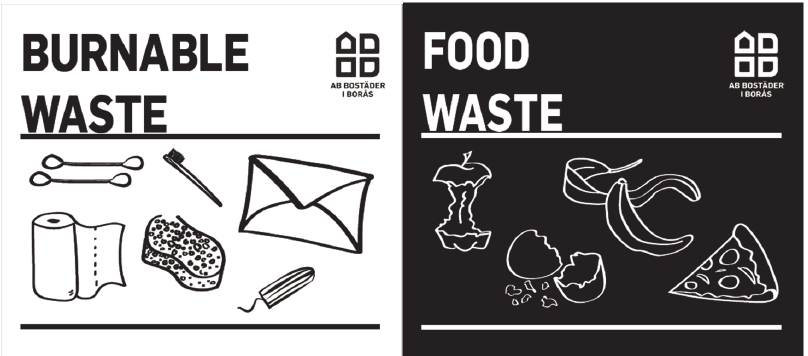
Figure A30. Stickers for the indoor bins.